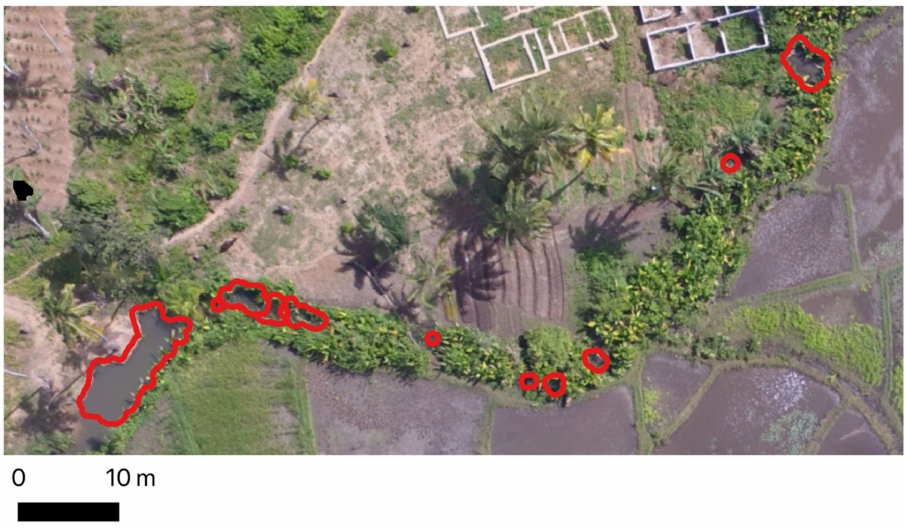
Figure 8. Riparian vegetation obscuring sections of an inundated stream